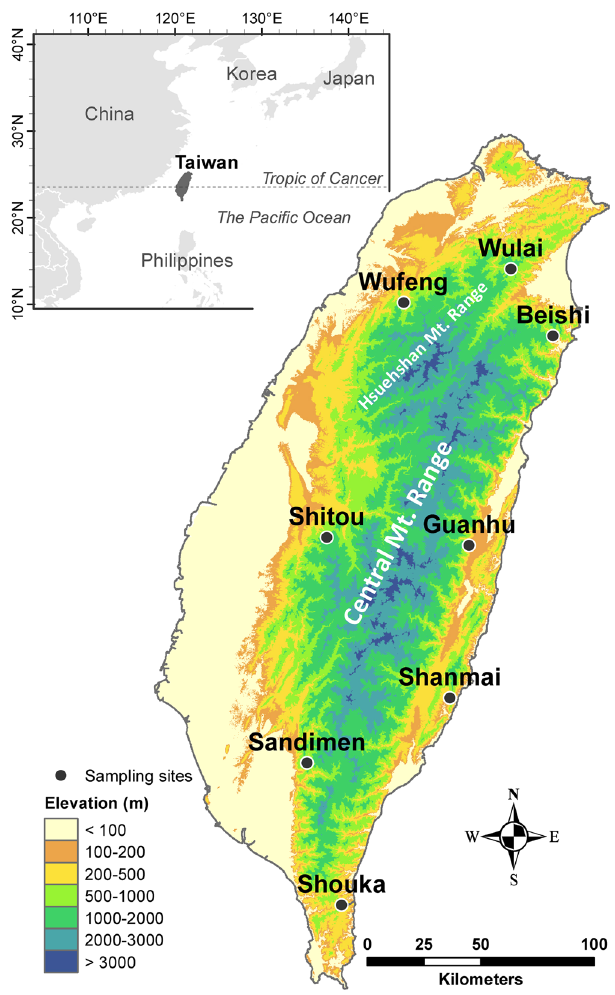
Figure 1. Sample localities of eight populations of Musa basjoo var. formosana . The countries’ boundary (polygon) map was derived from the default map database in ArcGIS v. 10.3 92 . The elevation gradients of Taiwan (background) were presented in ArcGIS based on the 20 m digital elevation model (DEM) that was acquired from Data.GOV.TW 93 . The locations of the sampling sites were plotted using Tools in ArcGIS by their